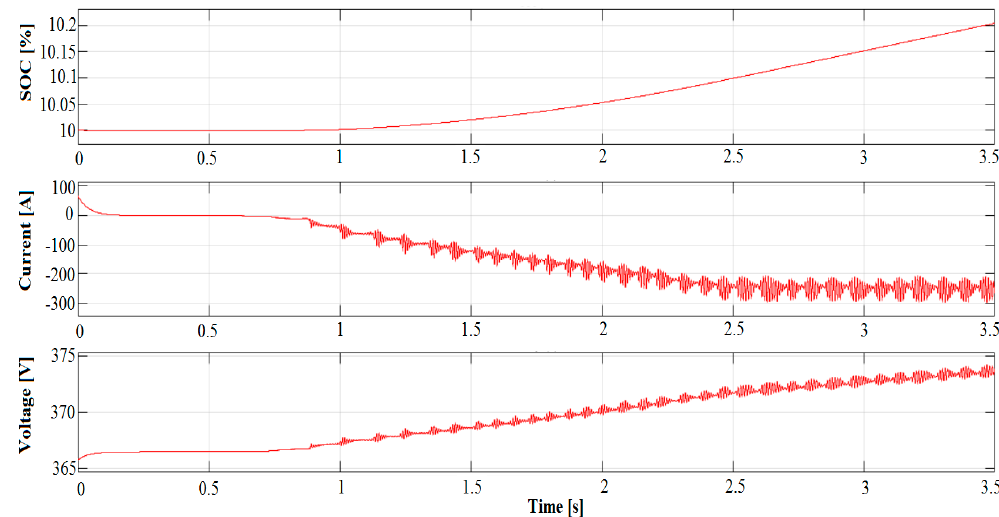
Figure 10. Battery main variables: state of charge, current and voltage.